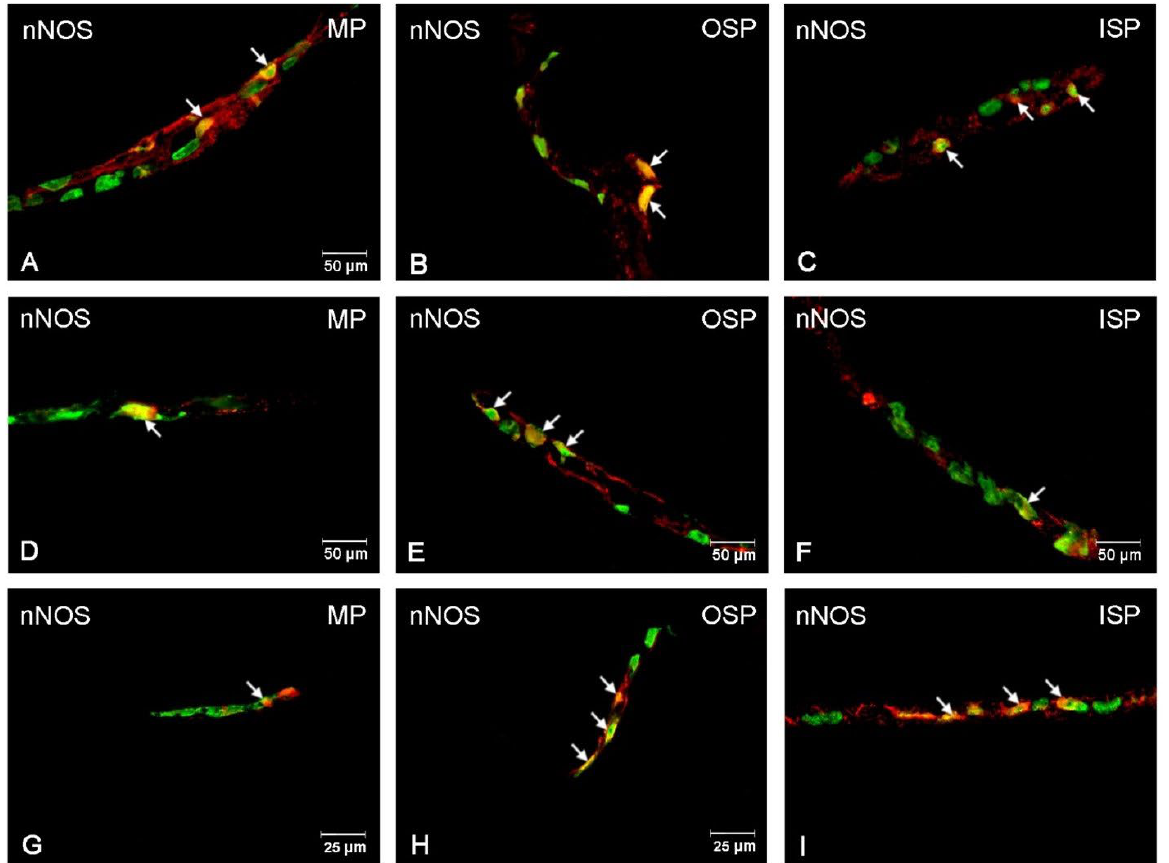
Figure 6. Fluorescence microscopy images showing protein gene product 9.5 (PGP 9.5) visible as green fluorescence that colocalizes with neuronal isoform of nitric oxide synthase (nNOS) visible as red fluorescence in the enteric neurons of the jejunum in pigs. The obtained images were created by computer superimposition of two channels (green and red). The photos show the enteric nervous sys- tem neurons of the pig’s jejunum under physiological conditions ( A , D , G ) and after administration of low ( B , E , H ) and high ( C , F , I ) doses of acrylamide. Neurons immunoreactive for particular substances are advisable with arrows. MP—the myenteric plexus; OSP—the outer submucosal plexus; ISP—the inner submucosal